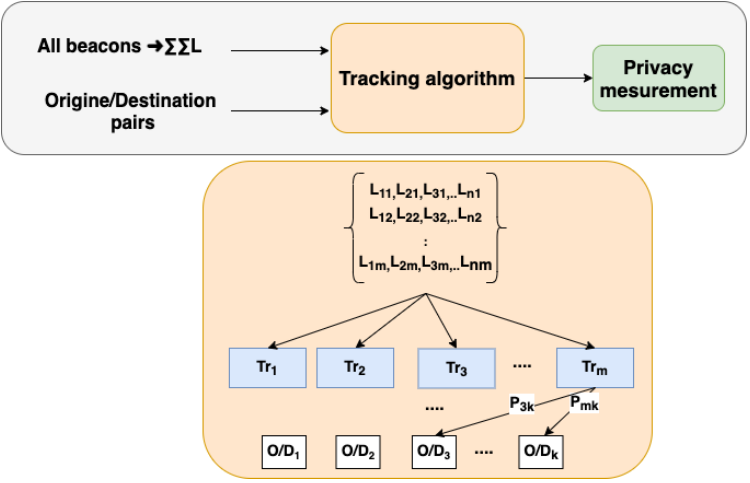
Figure 4. Tracking algorithm